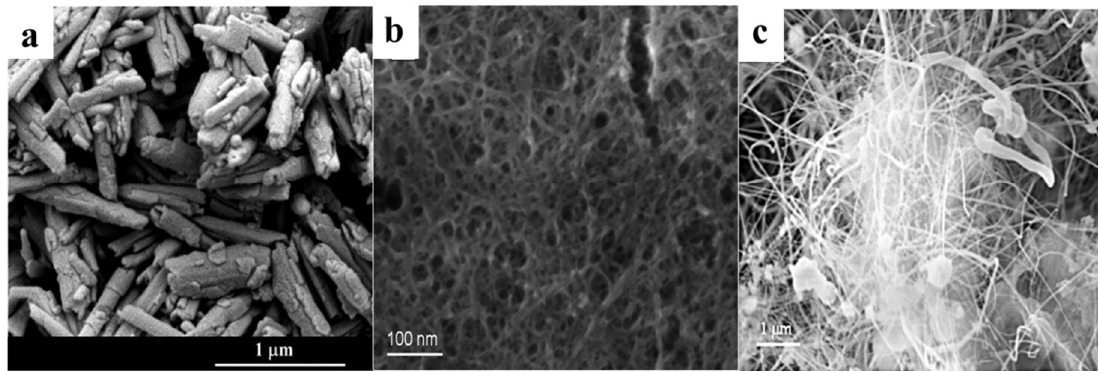
Figure 1. SEM images of ( a ) halloysite, ( b ) imogolite and ( c ) boron nitride nanotubes. Adapted from References [7,35,52].